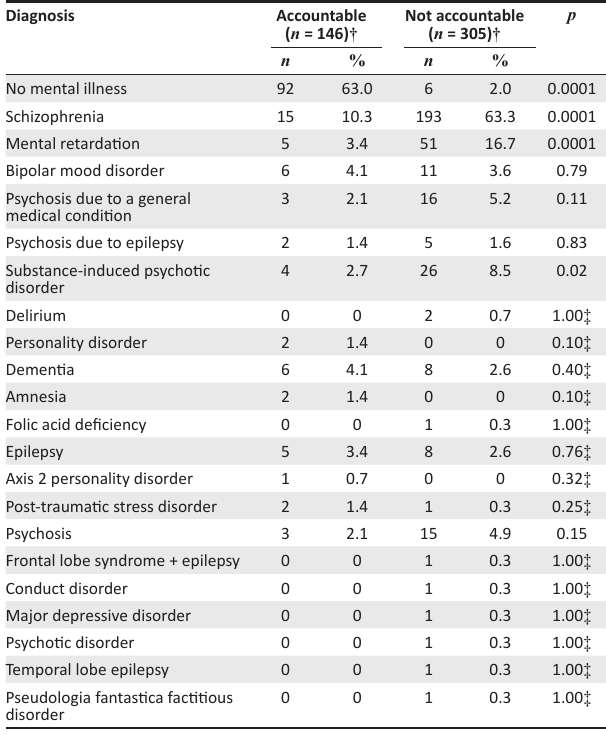
TABLE 6: Diagnoses of the observation. TABLE 4: Offences committed by observati against persons.